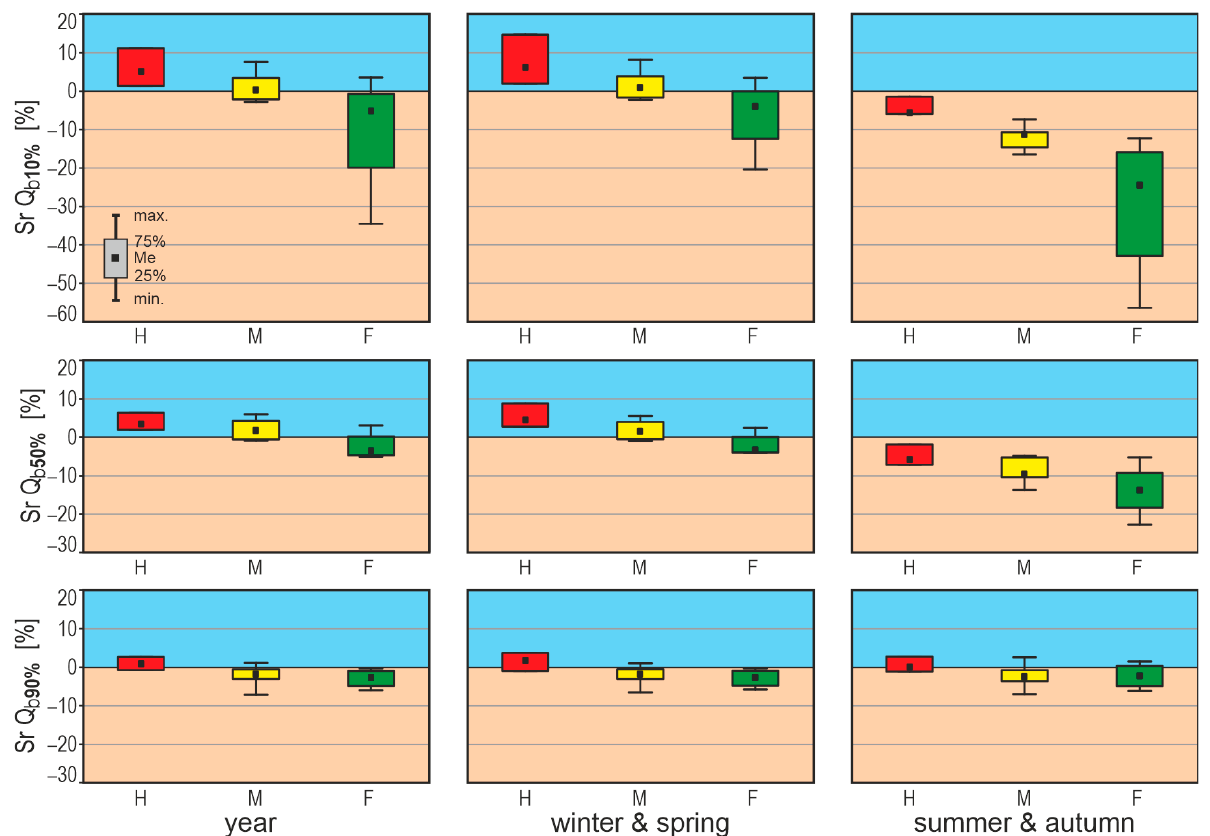
Figure 8. Relative changes of baseflow 10th, 50th, and 90th percentiles ( Q b, p ) in high mountains (H), medium mountains (M), and foothills catchments (F) in 1970–2019.